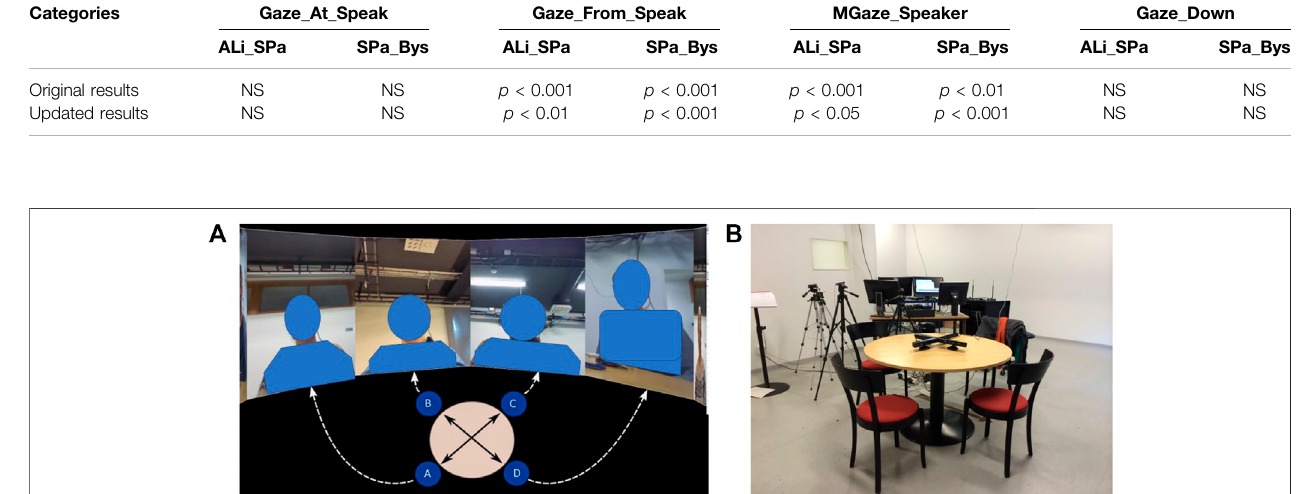
FIGURE 1 | Depictions of the KTH-Idiap Corpus. (A) Video Clip Arrangement. Annotation material. Annotators were given a 15 s video slice, as illustrated above. (B) Corpus Collection